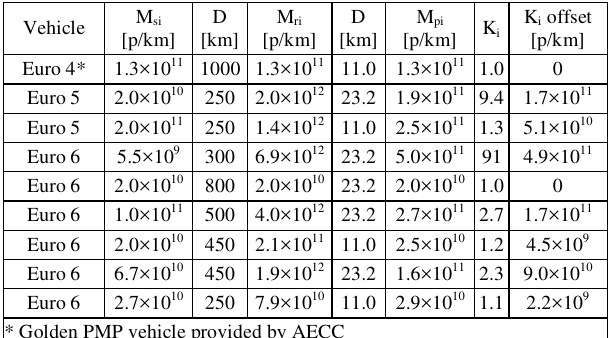
Table 2. Estimation of K i factors for regeneration [21, 26]. All vehicles equipped with DPF